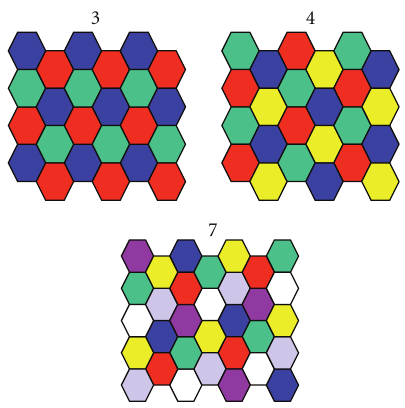
Figure 1: Frequency reuse schemes with 3, 4, and 7 colours.